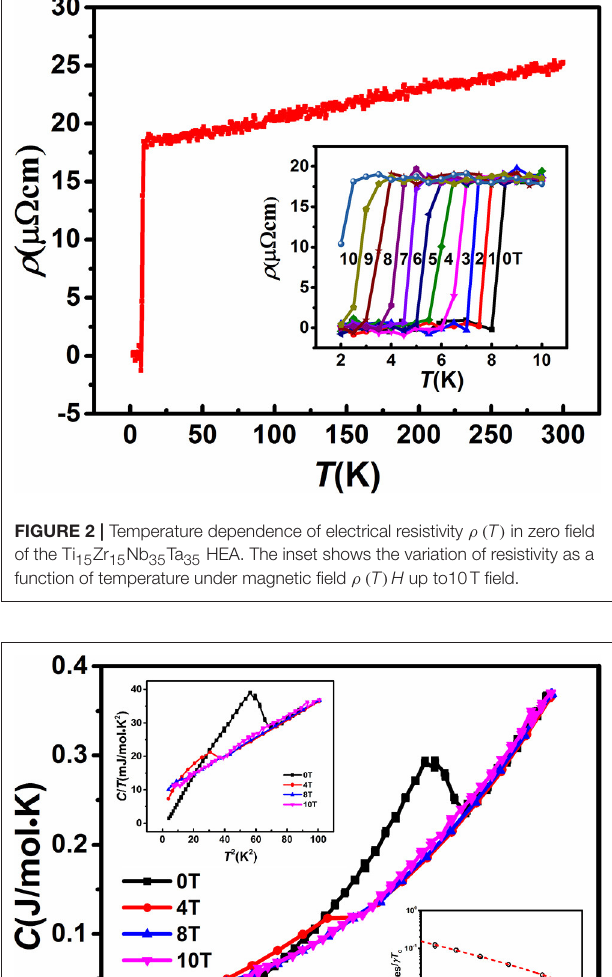
The upper critical field H c 2 corresponding to the temperatures where the resistivity drops to 90% of the normal state resistivity ρ ( T , H ) (see inset of Figure 2 ) at the onset critical temperature T onset determined from the intersection of the two extrapolated c lines of ρ ( T ) in the applied magnetic fields (Jha et al., 2014). The upper critical field H c 2 determined from resistivity (black circles) and from specific heat measurements (red squares)